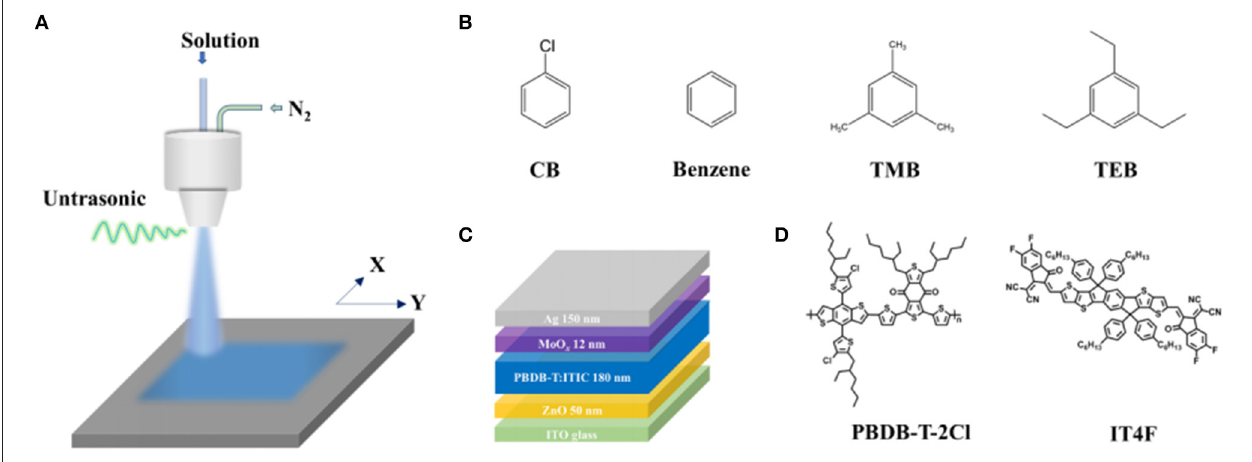
each device, is a quasi-semicircle. The real impedances Z’ has identical tendency with J SC as the solvent varies, implying that the conductivity of the devices with benzene and triple